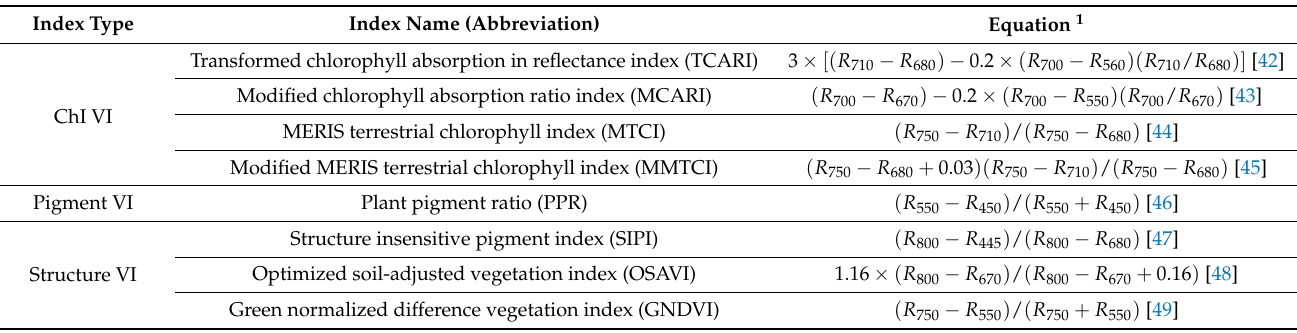
Table 1. Vegetation indices related to ChlF